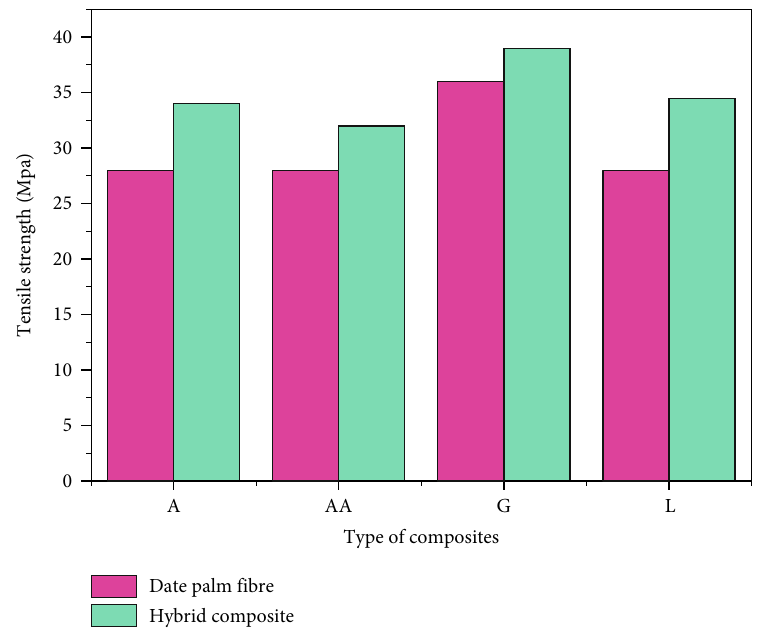
Figure 6: Tensile strength of DPF and hybrid composites.